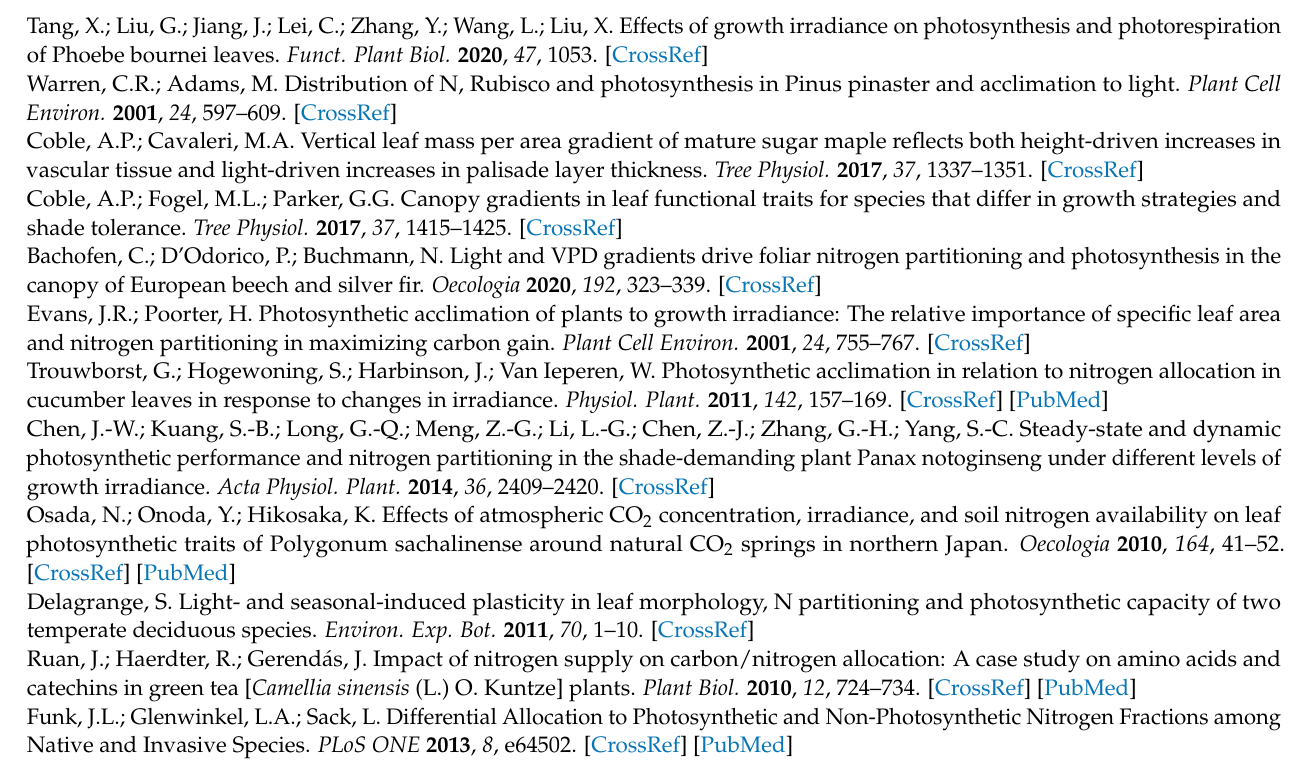
( Q Parea ), cell wall ( Q CWarea ), and other parts ( Q Other-area ) in four species seedling leaves under different irradiance treatments. Table S3: Quantity of leaf N per mass allocated to Rubisco ( Q Rmass ), bioenergetics ( Q Bmass ), light-harvesting components ( Q Lmass ), photosynthetic apparatus ( Q Pmass ), cell wall ( Q CWmass ), and other parts ( Q Other-mass ) in four species seedling leaves under different irradiance